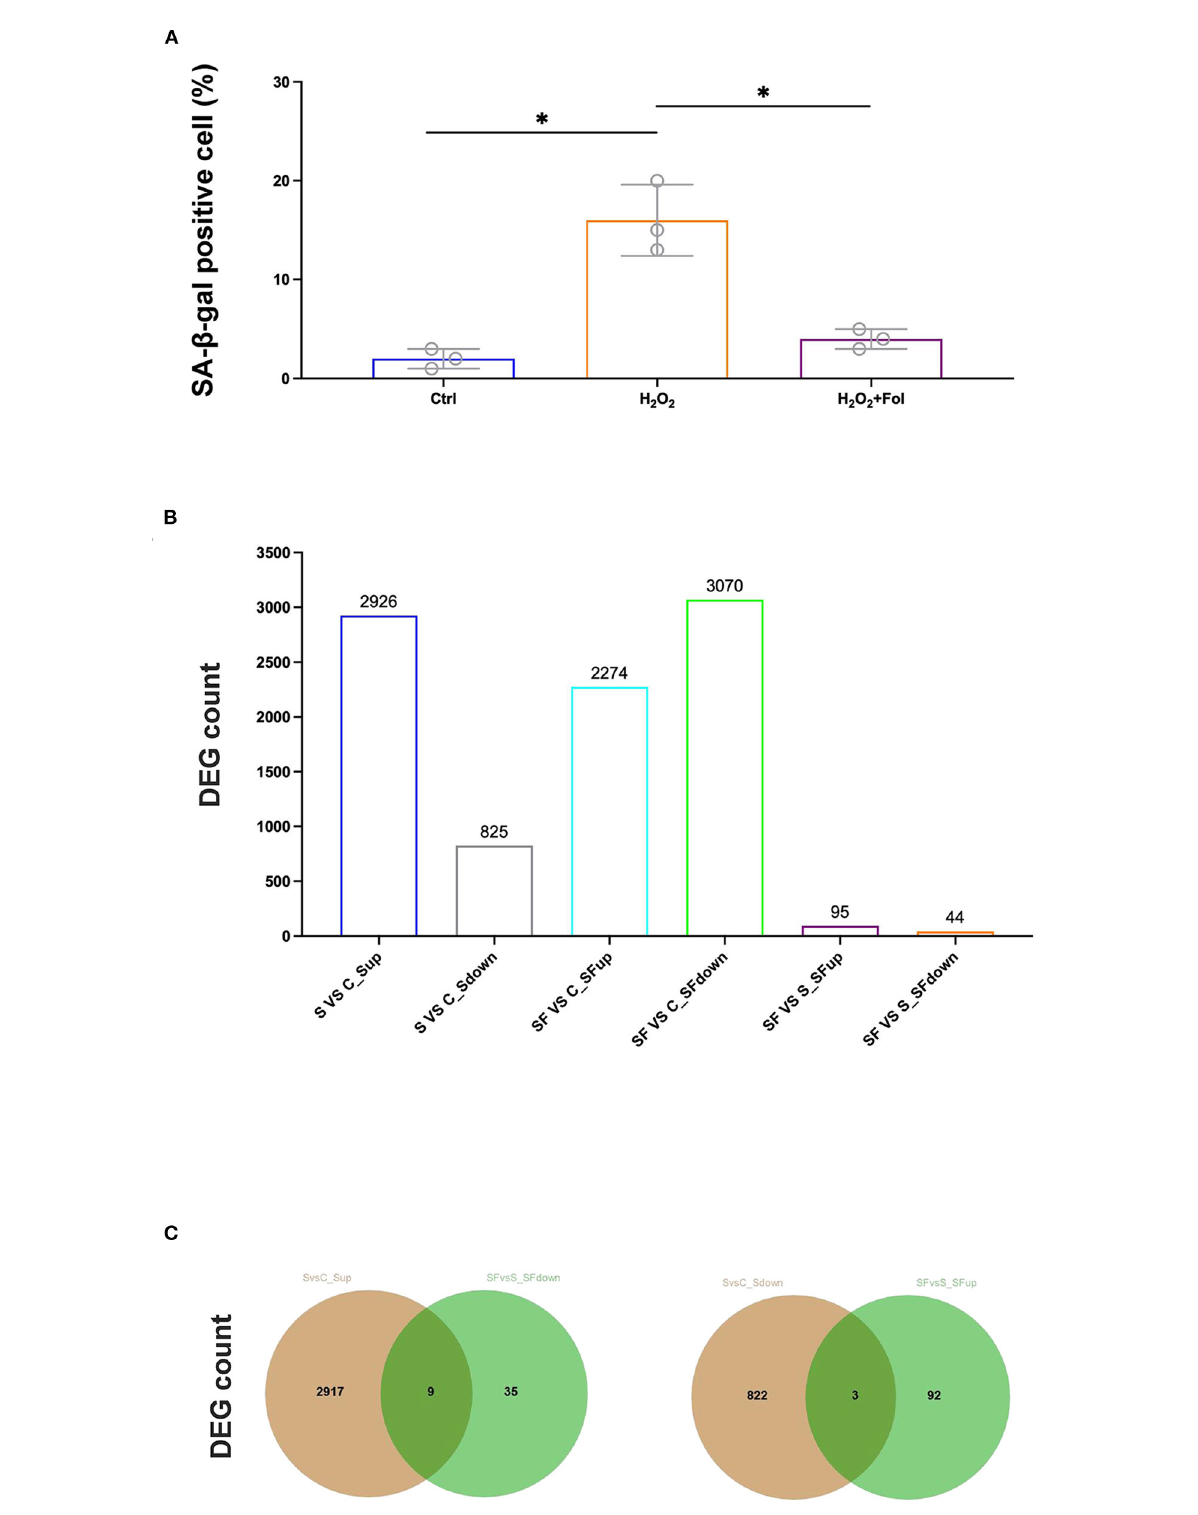
FIGURE3 Hub genes and pathways affected by H 2 O 2 and fullerenol. (A) ARPE-19 cells in the control group, H 2 O 2 group, and fullerenol group were stained with SA- β -Gal. (B) Counts of DEGs among all the groups. (C) The overlay of genes up-regulated after H 2 O 2 treatment and down-regulated after fullerenol treatment is showed in the left panel, while genes down-regulated after H 2 O 2 treatment and up-regulated after fullerenol treatment is showed in the right panel. Fol, fullerenol; S, H 2 O 2 group; C, Ctrl group; SF, Fullerenol group. * p <